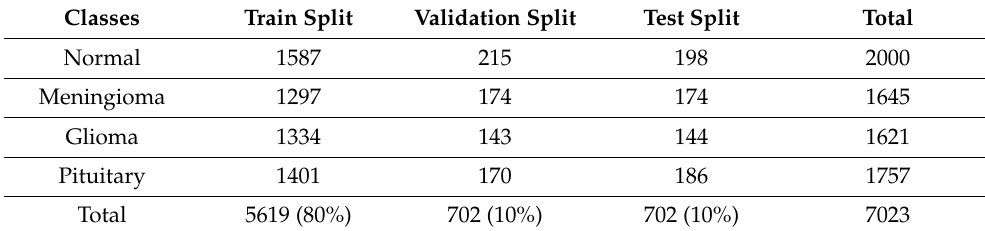
Table 2. Information about DS-2 (Dataset-2)